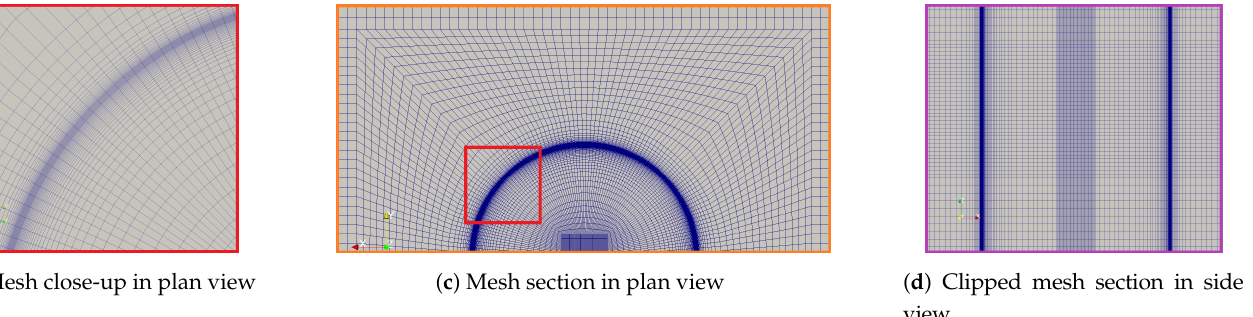
Figure 3. CFD model setup: ( a ) sketch of the model configuration for both the 2D and 3D numerical flume, ( b – d ) sections of the mesh of the 3D model with the cylinder represented by porous media where ( b , c ) show sections in plan view and ( d ) the side view of a clip across the vertical x − z symmetry plane. The colours of the rectangles in ( a ) correspond to the colours of the frames of ( b – d ). ( a ) Sketch of the model configuration for both the 2D (side view only) and 3D (plan- and side view) numerical flume, all dimensions in [m]. The positions for the WGs A2 and A5 vary between the 2D sheet model and cylinder—the dimensions for the 2D model are stated in brackets ( b ) Mesh close-up in plan view ( c ) Mesh section in plan view ( d ) Clipped mesh section in side